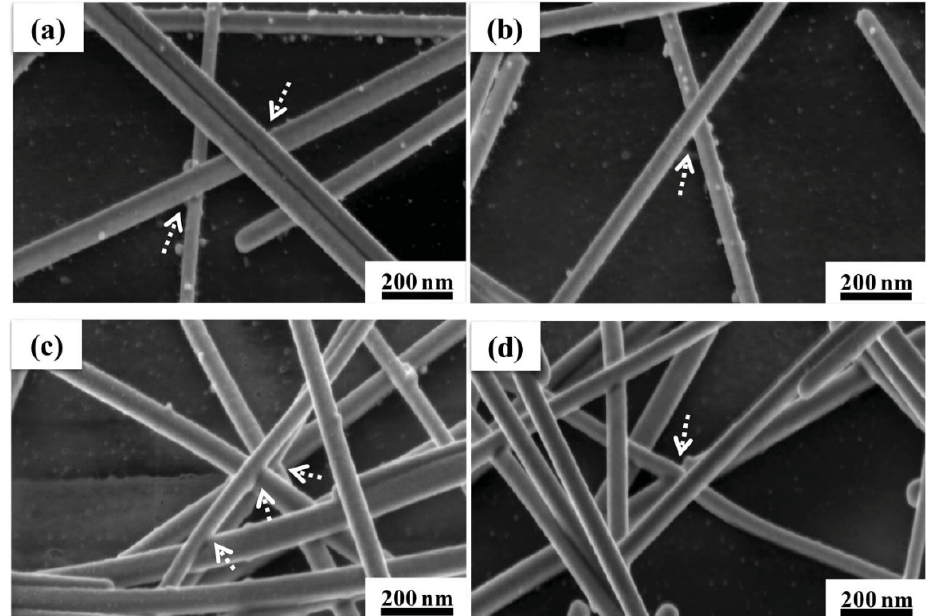
Figure 7. SEM images of un-annealed silver nanowire networks ( a , b ) before bending, ( c ) after imposing 10,000 bending cycles, and ( d ) after 500,000 bending cycles. Reproduced with permission from ref. [28]. Copyright 2014, Wiley.